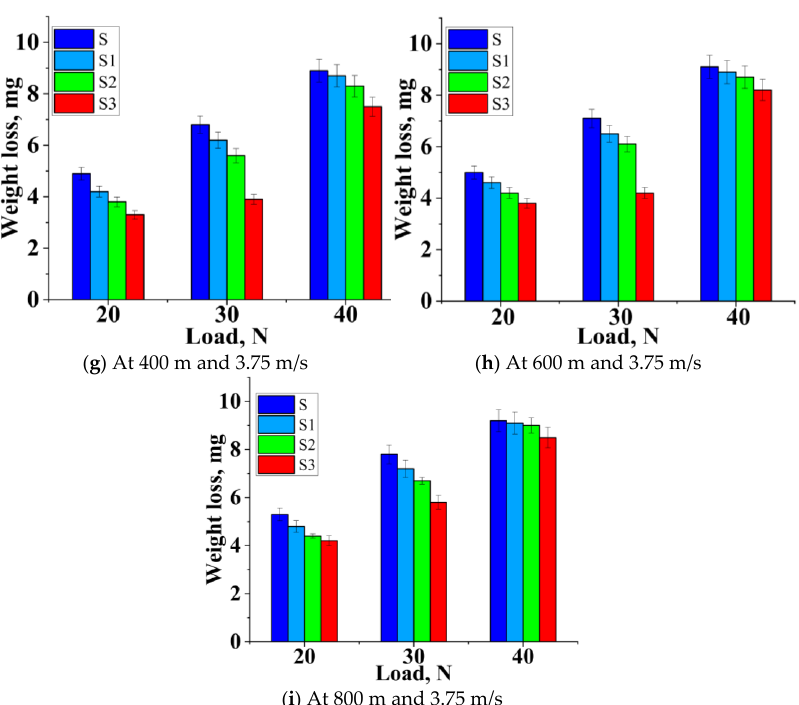
Figure 7. Effect of load vs. weight loss at different sliding velocities and distances ( a – i ). When the load was higher than 30 N with a sliding speed of 2.75 m/s, there was an